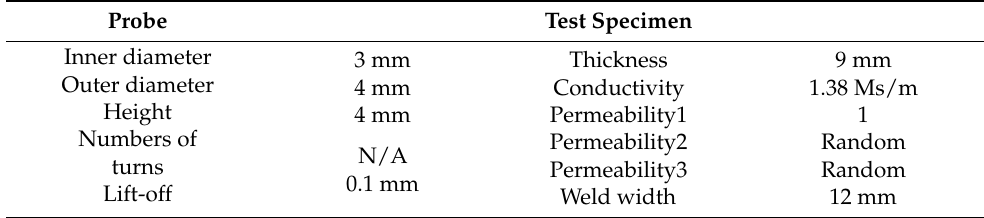
Figure 2. The structure of joined pipe and the configuration type eddy current nondestructive testing technique (EC-NDT). Table 1. Test setup parameters.